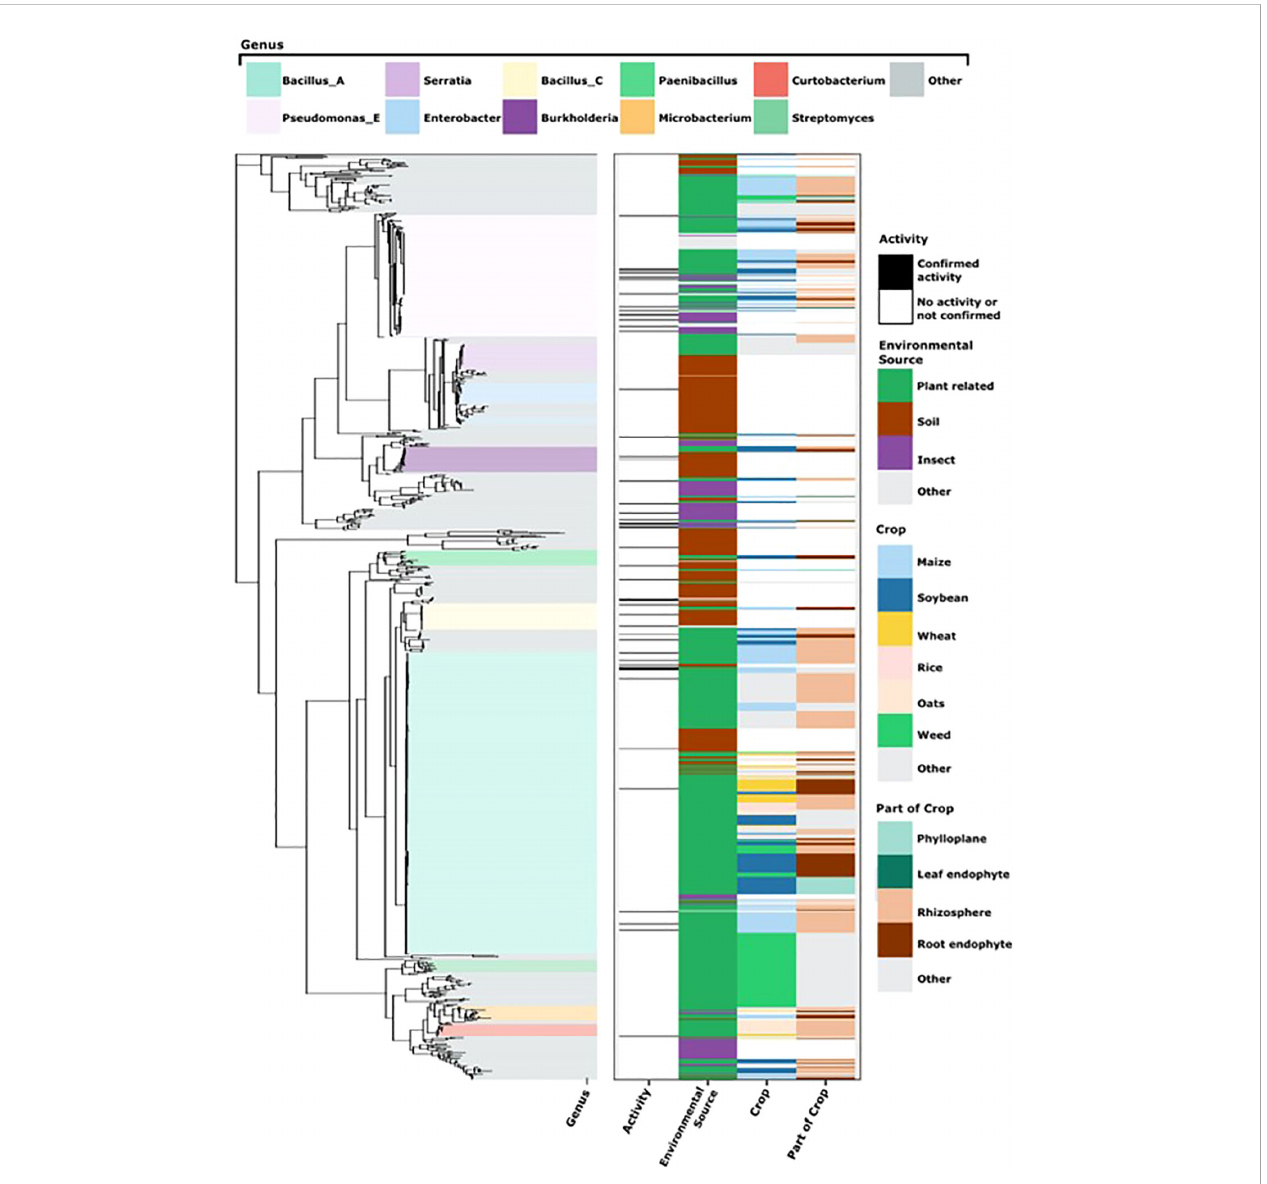
FIGURE 2 Metadata associated with bacterial isolates evaluated in the initial screen. On the left is the SSU phylogenetic tree with the most abundant genera highlighted as classi fi ed by the Genome Taxonomy Database (GTDB) (see key at the top). On the right we indicate activity against soybean rust (at least 75% reproducible rust reduction), environmental source of the isolate, and for plant-associated isolates, the crop, and the part of the crop/plant from which bacteria were isolated (see key to the